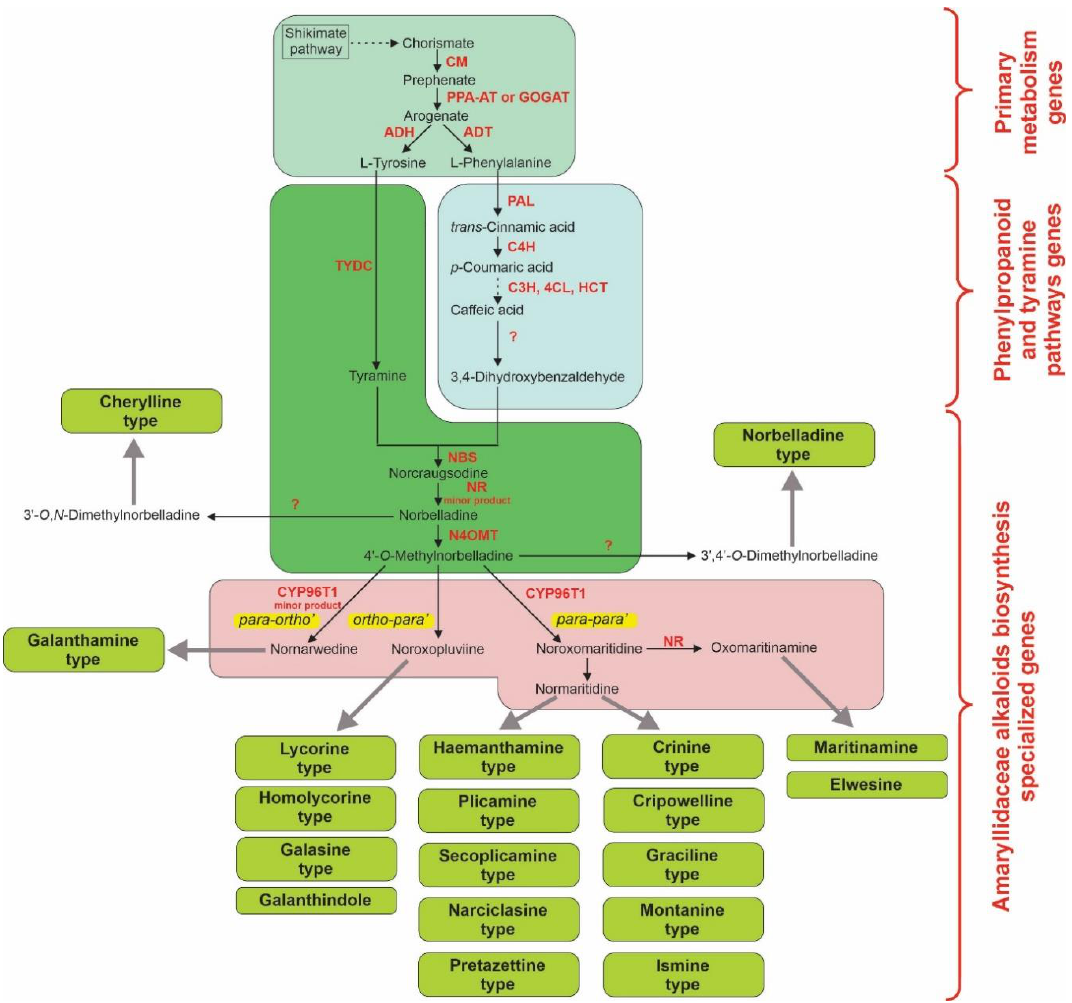
Figure 2. Schematic presentation of the proposed biosynthetic pathway of Amaryllidaceae alkaloid biosynthesis in plants. The five stages of the pathway are presented in different colors. The dashed arrows represent multiple reactions. The bold grey arrows indicate specialized pathways leading to the biosynthesis of different types of Amaryllidaceae alkaloids. The known enzymes are written in bold red font. Abbreviations: CM—chorismate mutase; PPA-AT—prephenate